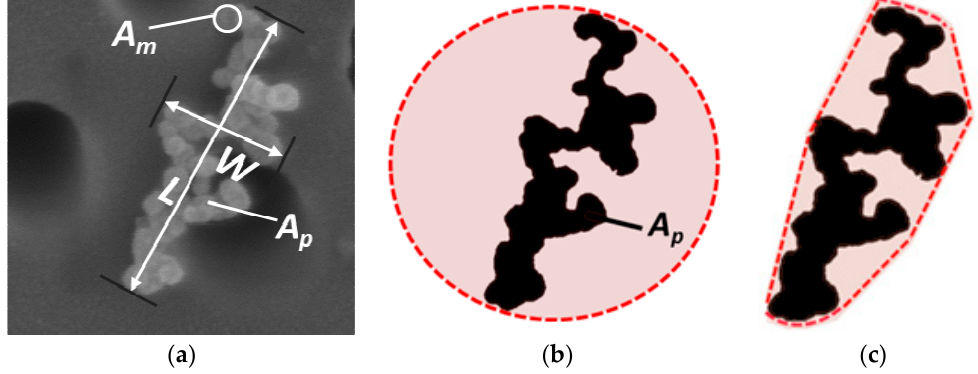
Figure 2. ( a ) Example of SEM image of a soot particle showing the definition of several parameters measured from the projected image: maximum projected length L , maximum projected width W , projected area of monomer A m and projected area of particle A p . ( b ) Schematic representation of the roundness calculation for the same soot particle shown in ( a ). ( c ) Schematic representation of the convexity calculation for the same soot particle shown in ( a ). The pink shades in ( b , c ) represent the equivalent area for a circle and the convex hull, respectively, for the binary image of the soot particle shown in ( a ).